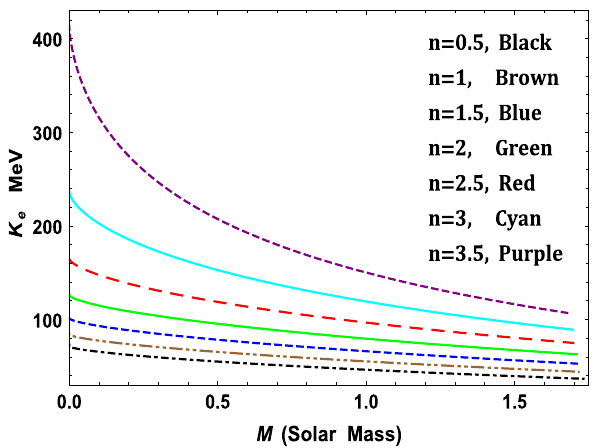
Fig. 15 Variation of adiabatic index with radial coordinate r for 4U 1608-52 ( M = 1 . 74 M (cid:9) , R = 9 . 528 km) by taking a = 0 . 001 km − 2 and β = 0 . 01